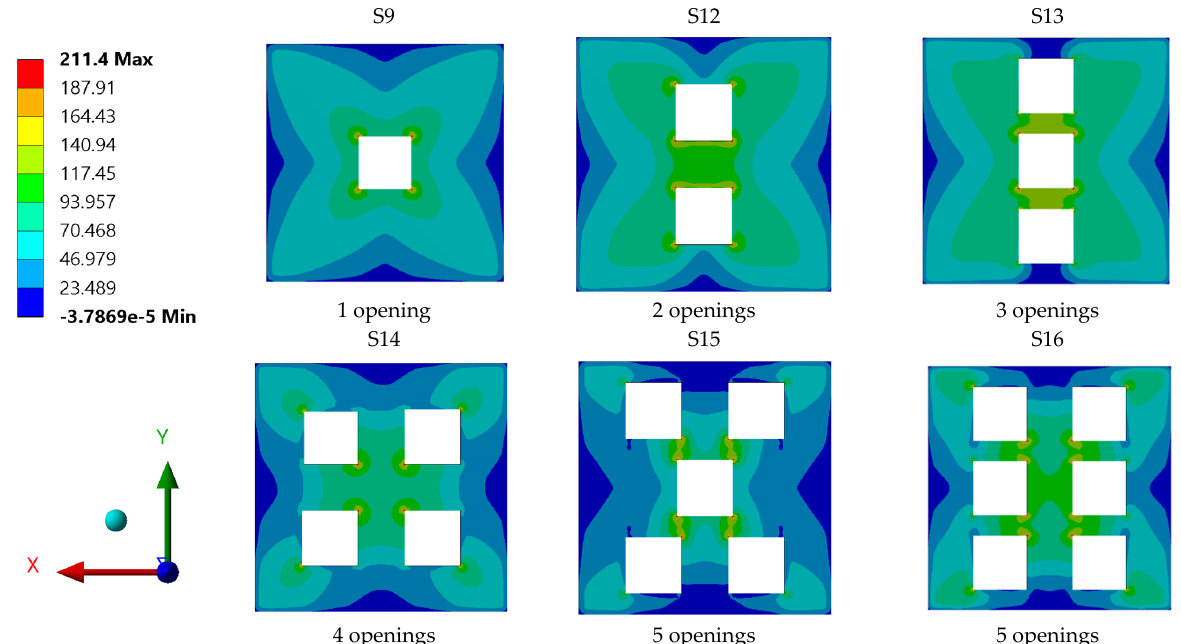
Figure 19. Stress distribution contours for individual steel plates with different plate opening num- bers.